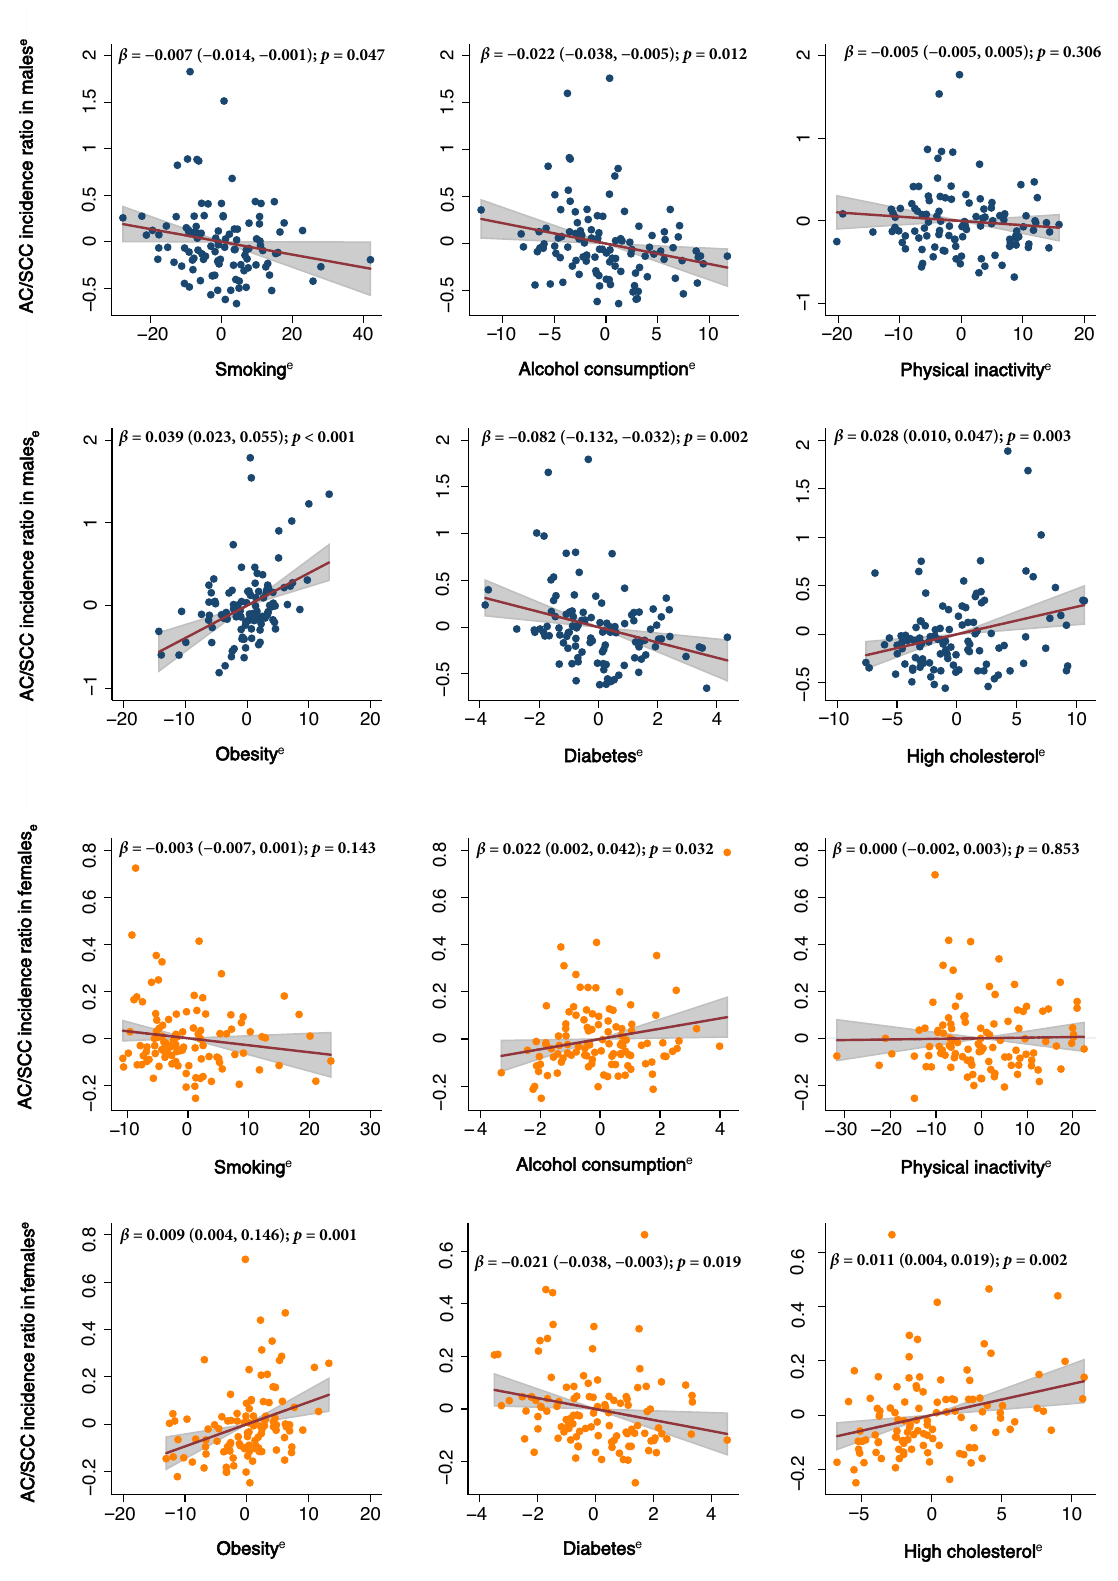
Figure 3. The risk factors associated with histological subtypes ratio of esophageal cancer